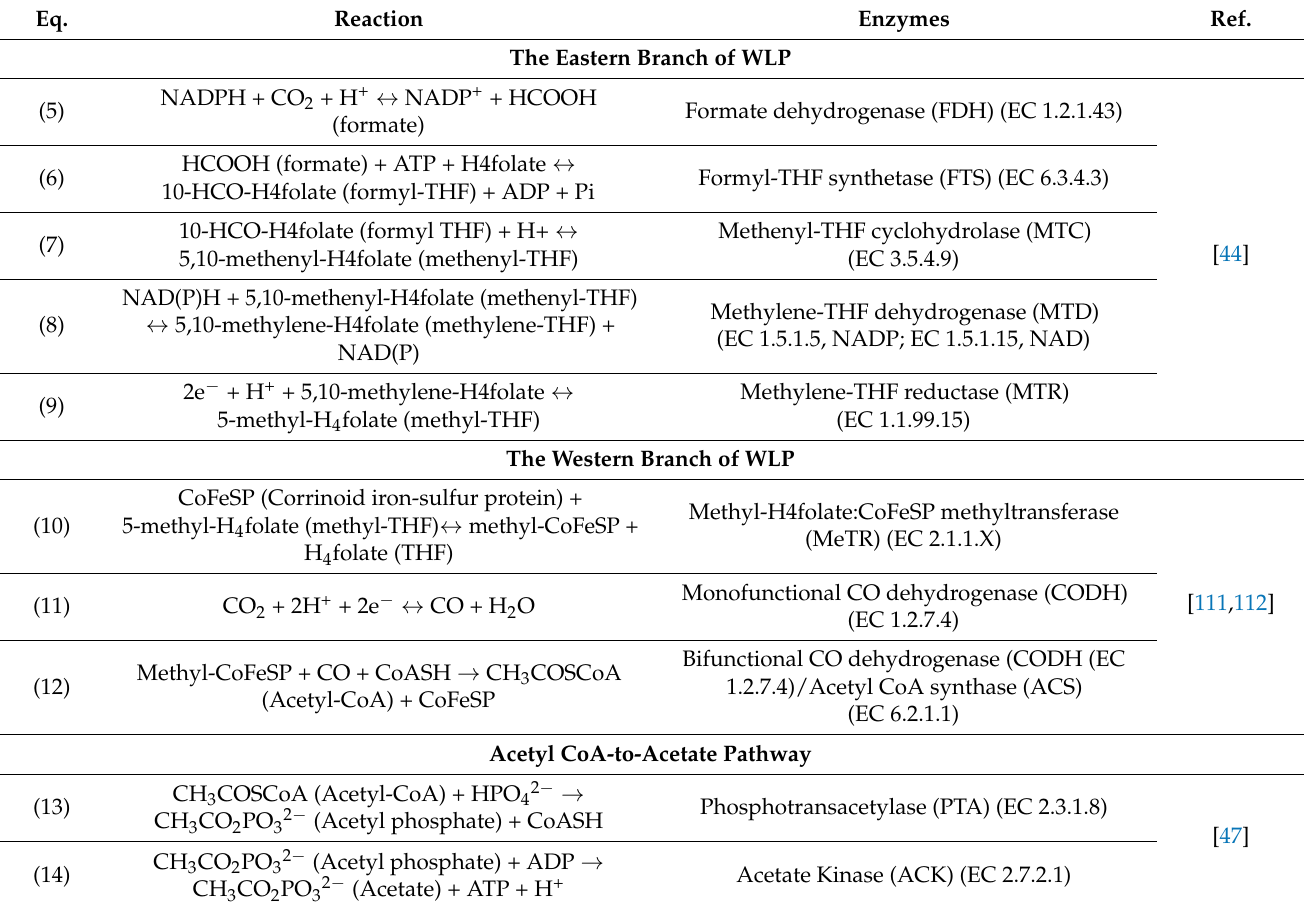
Table 5. Detailed metabolic reactions of Wood–Ljungdahl Pathway